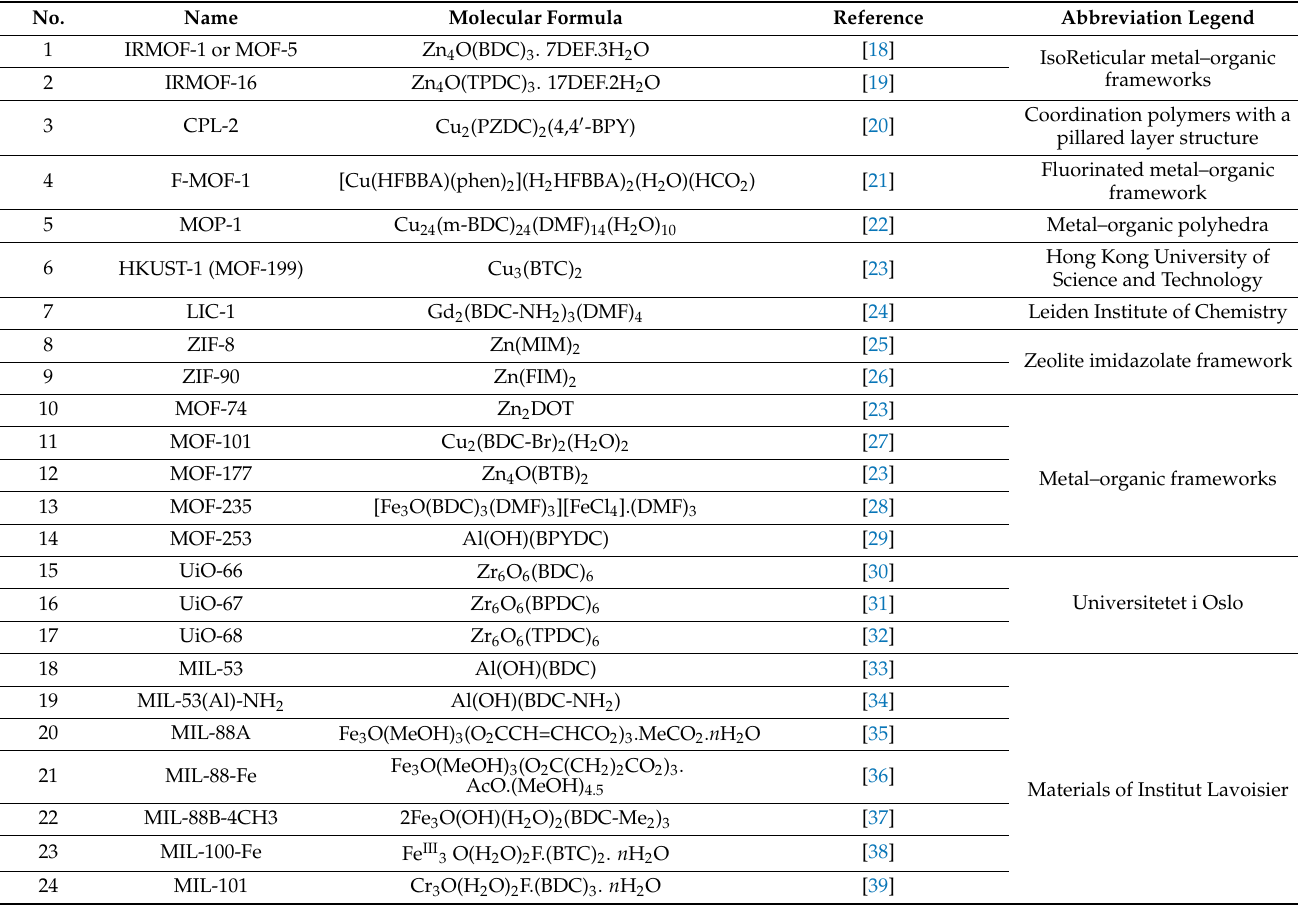
Table 1. Example of typical names for metal–organic structures (MOF) with the description of their molecular